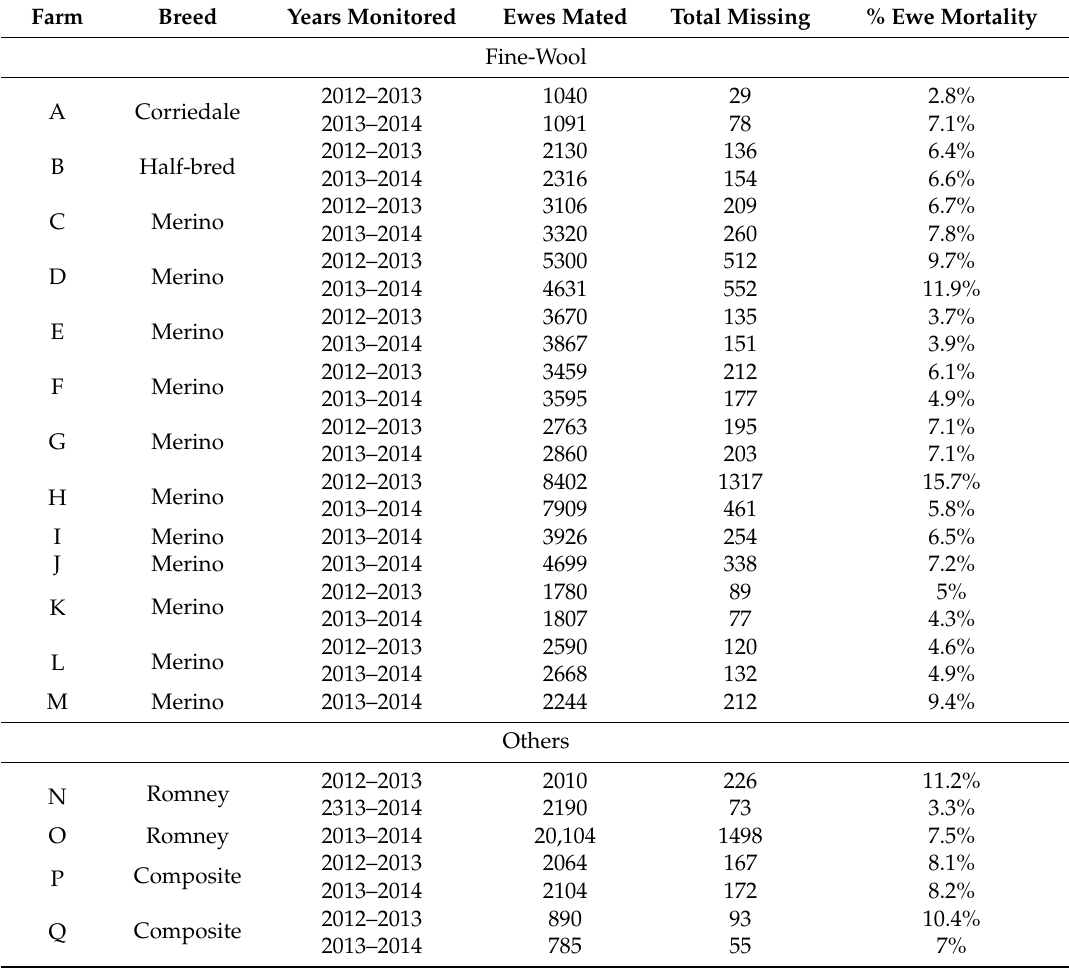
Table 1. Flock tallies of study farms by